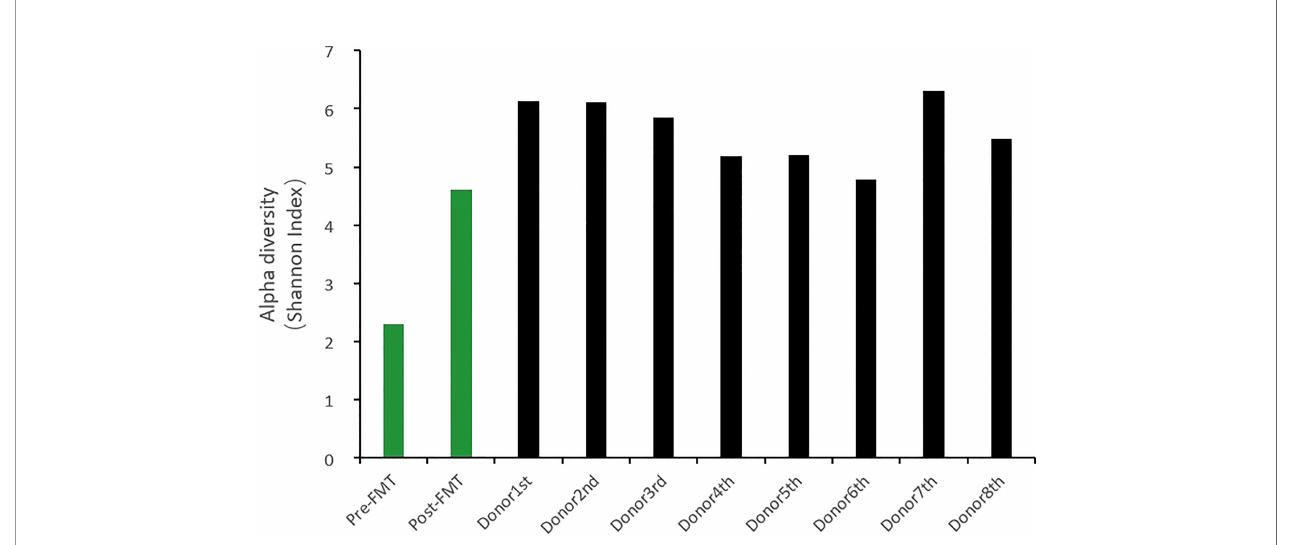
FIGURE 5 | Donor1-8: 16S sequencing of the micro fl ora abundance of the donor regularly monitored one year before donation (about every one and a half months or so) within 1 year. The data of the stool at the 8th time is the closest to the stool received by the patient. Compared with the healthy FMT donor, the alpha diversity before treatment was different, as measured by the Shannon index, and the gut microbiota diversity of patients became similar to the donor after